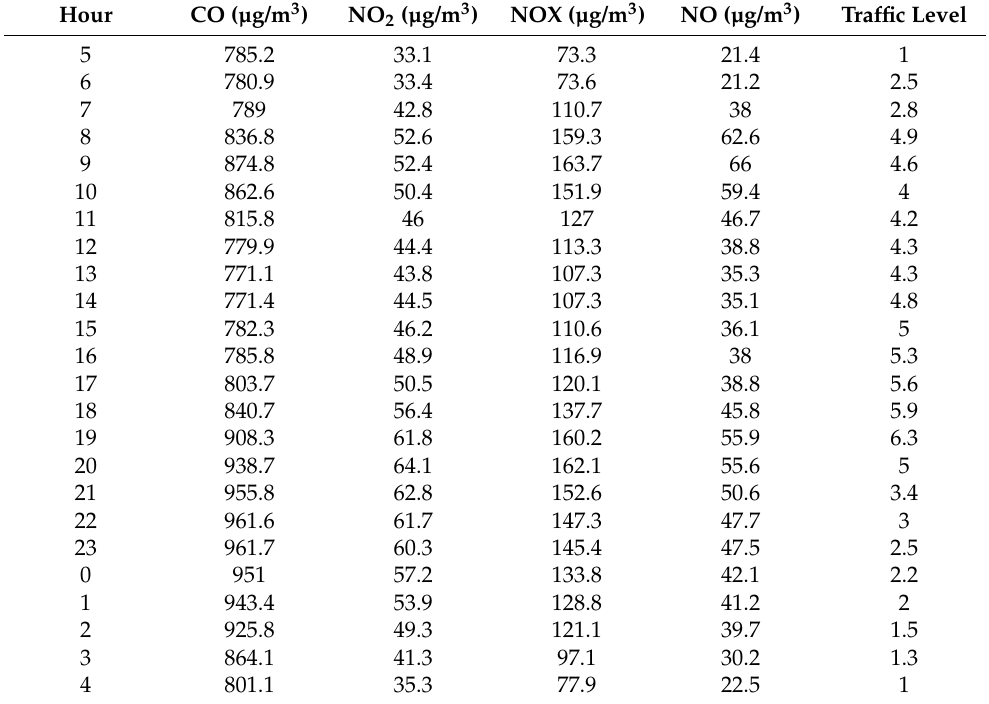
Table 1. Air quality indicators and traffic density for Istanbul June–August 2022 for selected city center